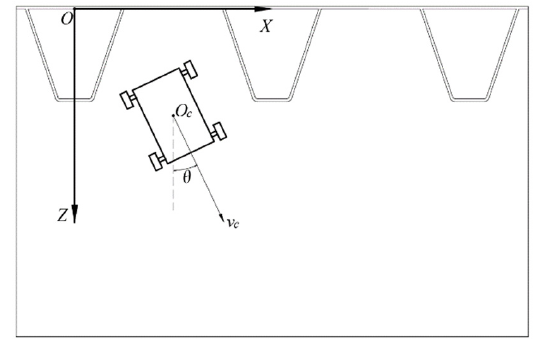
Figure 10. Pose of the robot steering to adjacent lane.